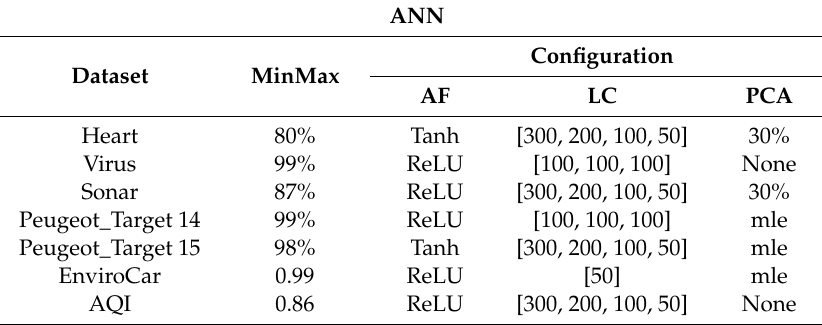
Table 15. Performance and configuration of ANN with MinMax scaling.